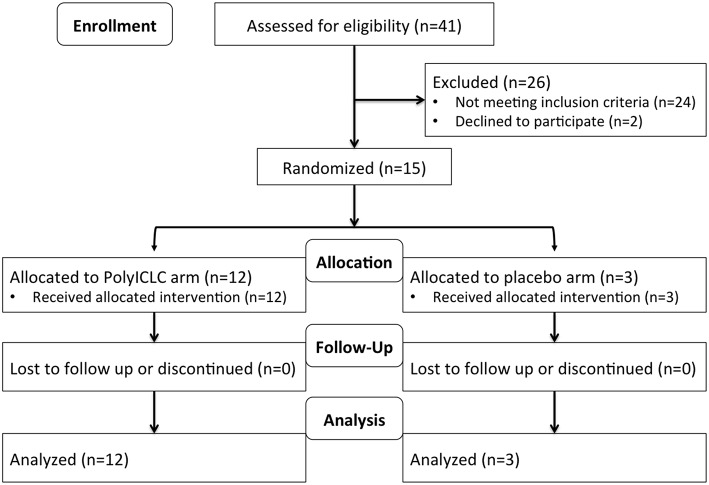
Study flow diagram.